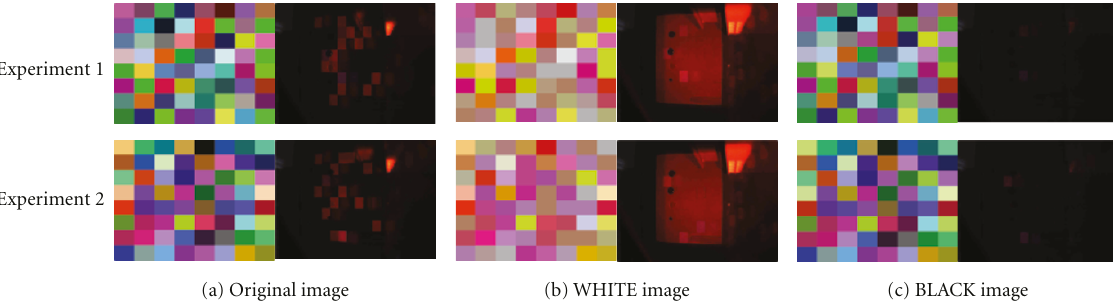
Figure 16: Color conversion using the proposed approach. (a) is the randomly generated 64 colors before conversion. (b, c) are (a) images after converted to the WHITE and BLACK set, respectively. Images in (b) represent the concept of nonintrusive projection used in this paper. Note that for each paired image, the right image shows the environment as seen by the synchronized camera when the left image is being projected from the